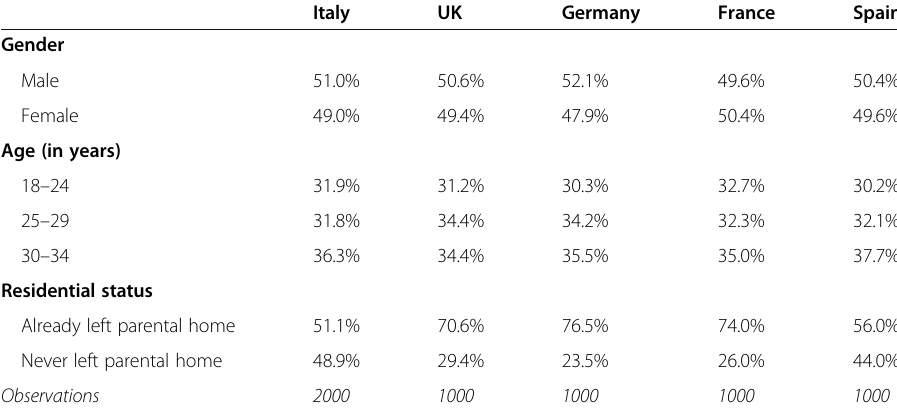
Table 1 Descriptive statistics of the total sample